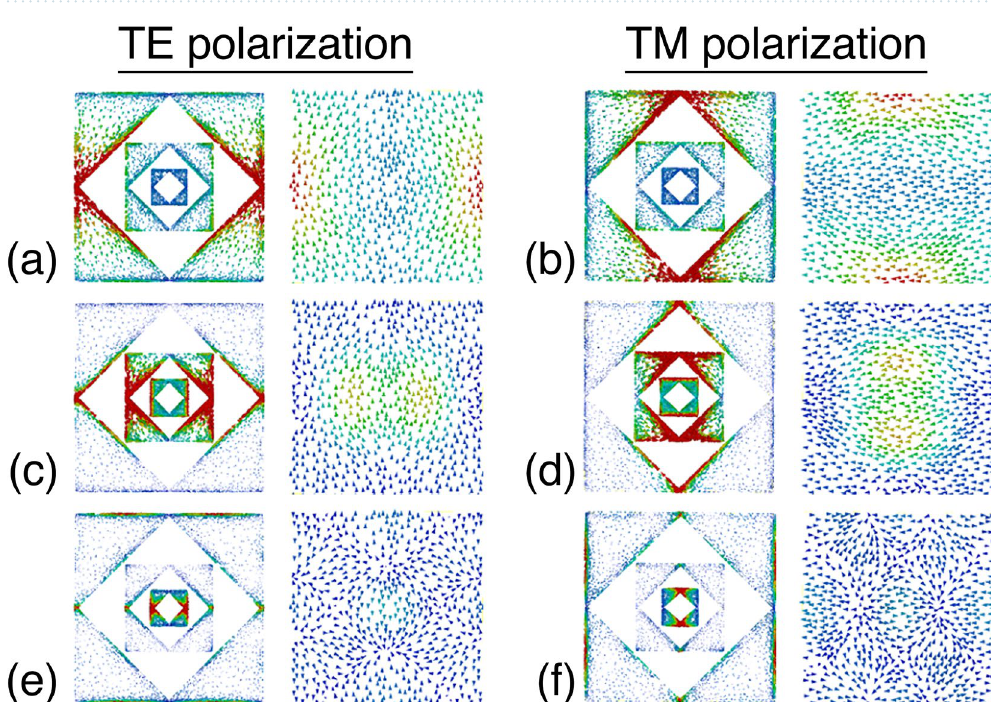
Figure 6. Surface current distributions on the top and bottom layer at ( a ), ( b ) 1.16THz; ( c ), ( d ) 3.41THz; ( e ), ( f ) 7.84THz for TE and TM polarization, respectively. The figure was edited using Adobe Photoshop CC 2022 (Version 23.4.1, https:// www. adobe. com/ produ cts/ photo